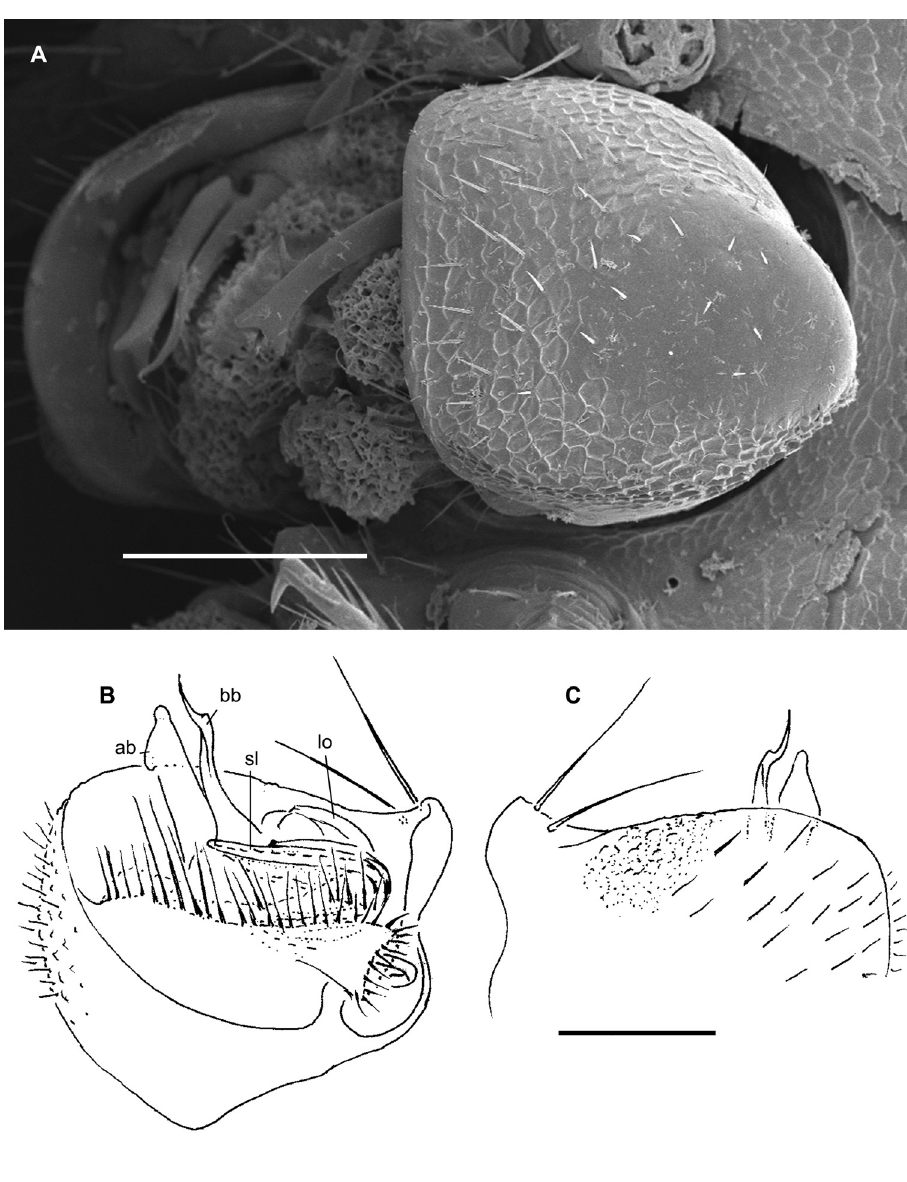
Figure 4. Hemisphaeroparia zamakoe sp. n., ♂ paratypes A SEM micrograph of both gonopods in situ, ventrolateral view B, C right gonopod, mesal and lateral views, respectively. Scale bars: 0.1 mm. Abbrevia- tions: ab apical branch of telopodite, bb basal branch of telopodite, lo lobe, sl